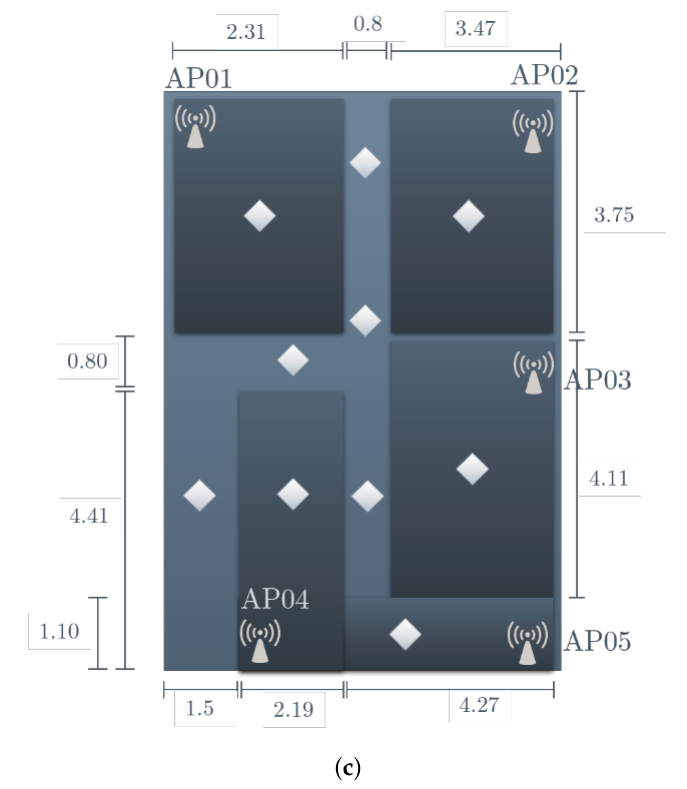
Figure 1. Testing scenarios for the proposed Indoor Positioning Mobile Application